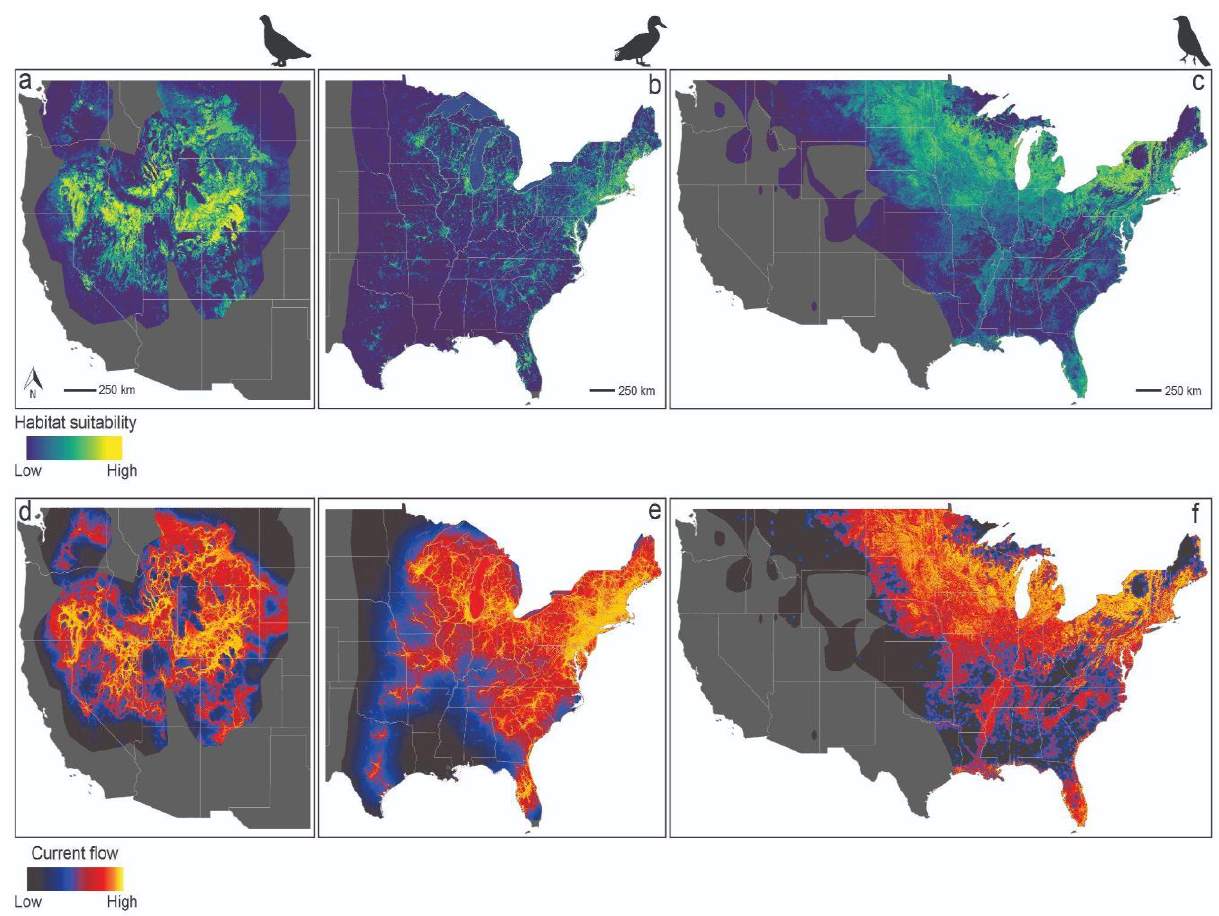
Figure 3. Habitat suitability (as predicted from random forest models) and the predicted probability of movement (i.e., current flow, as predicted from circuit theory-based connectivity models) for Greater Sage-Grouse in all seasons ( a , d ), American Black Duck during spring and fall migrations ( b , e ), and Bobolink during the breeding season ( c , f ). Model results are shown across each species’ geographic range in the U.S. (based on IUCN range maps, see text for